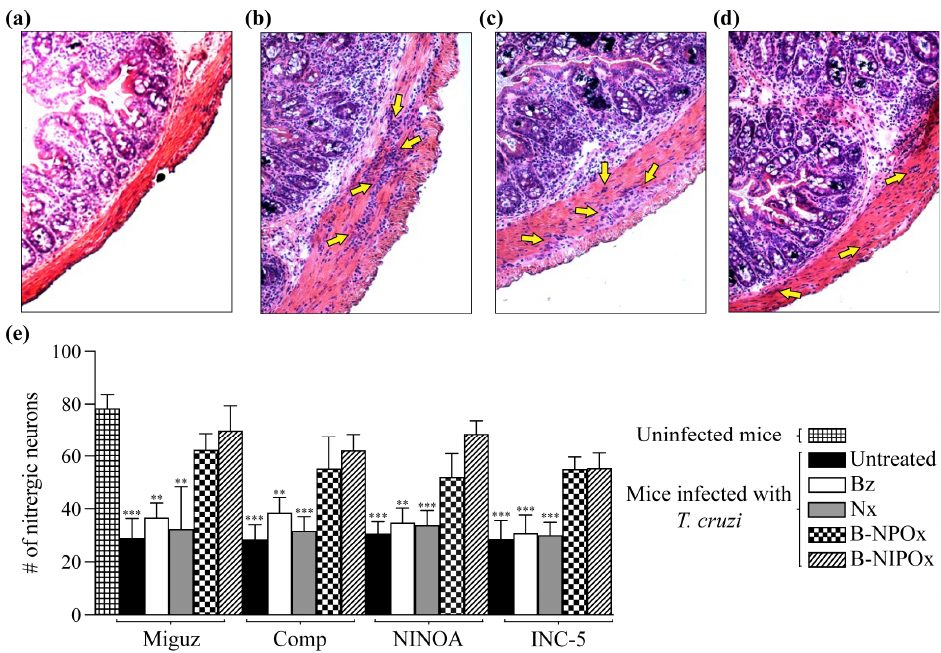
Figure 8. The benzyl ester of N-propyl oxamic acid (B-NPOx) and the benzyl ester of N-isopropyl oxamic acid (B-NIPOx) prevent leukocyte infiltration in the intestinal inner circular muscle layer, and the loss of nitrergic neurons in the intestine of mice infected with Trypanosoma cruzi . Repre- sentative photographs (40×) of recto-sigmoid large intestinal slides of CD-1 mice, ( a ) uninfected or ( b – d ) infected with the NINOA T. cruzi strain and treated with ( c ) Benznidazole (Bz) or ( d ) B-NIPOx (daily dosing at 100 mg/Kg for 50 days). The yellow arrows indicate the leukocyte infiltration in the intestinal inner circular muscle layer. The nitrergic neurons of uninfected mice, or of mice infected with the Miguz, Compostela (Comp), NINOA or INC-5 T. cruzi strains, were counted in recto-sigmoid large intestinal slides stained with NADPH diaphorase. The infected mice had been treated with Bz, Nifurtimox (Nx), B-NPOx or B-NIPOx with daily dosing at 100 mg/Kg for 50 days. ( e ) Asterisks represent statistically significant differences between the nitrergic neurons of the recto-sigmoid large intestinal of mice infected with the T. cruzi strains, compared with the uninfected mice (** p ≤ 0.01 and *** p ≤ 0.001). n = 6. One experiment representative of three is